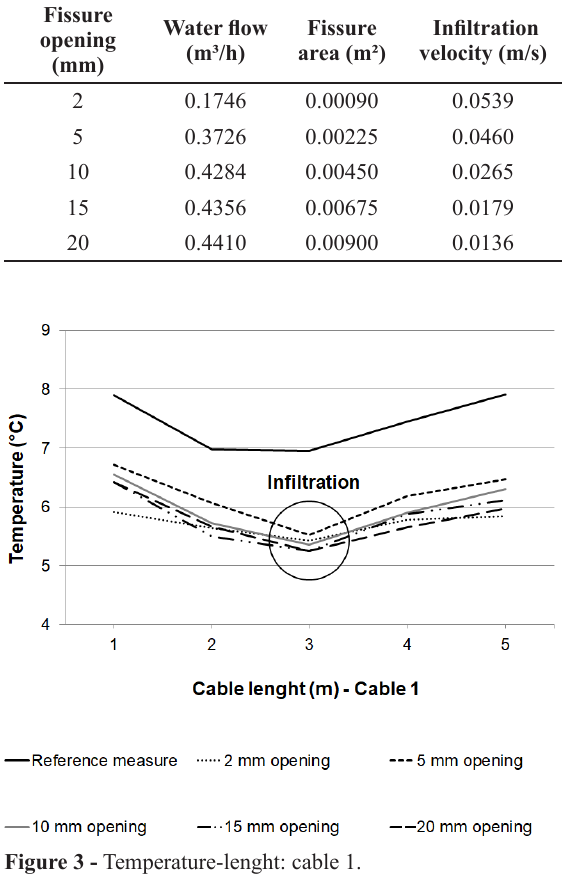
Figure 3 - Temperature-lenght: cable 1.